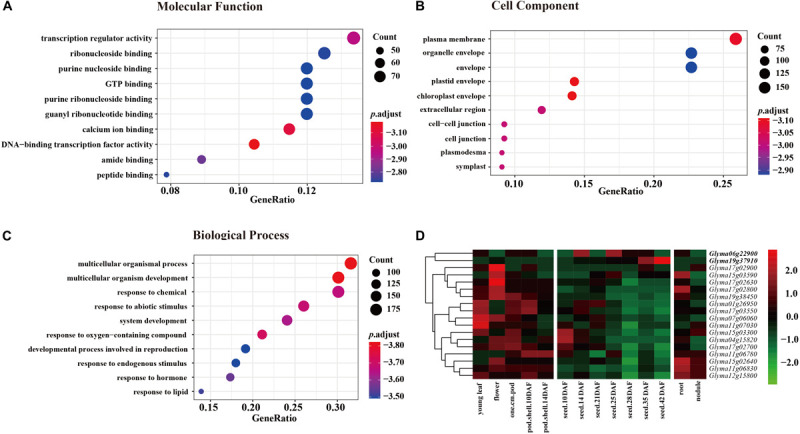
GO enrichment of 498 genes in three categories each with 10 groups and expression levels of 18 genes in 9 JQSs. For GO enrichment, p value < 0.01, q value < 0.05, and p value were corrected with Fisher’s exact test to obtain the p.adjust value, and were then transformed into –log10 (–log10 [p.adjust]). (A) GO enrichment of molecular function. (B) GO enrichment of cell component. (C) GO enrichment of biological process. (D) Heatmap of expression data for 18 candidate genes. Reads per kilobase of transcript per million mapped read values are normalized by row. Genes in boldface have high expression in seed tissues and low expression in other tissues.